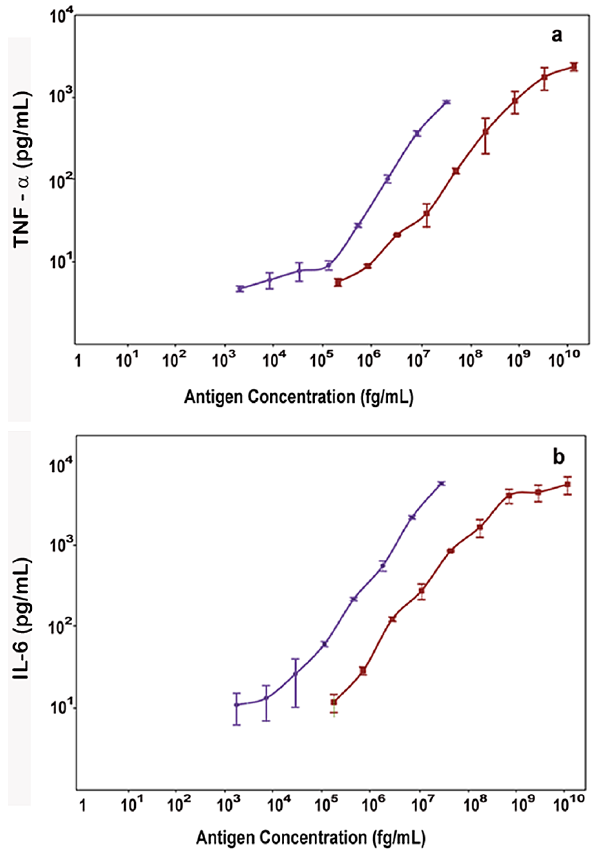
Figure 3. Measurement of the endotoxin activity of the NOMV vaccine. Measurement of endotoxin activity of the NOMV vaccine by the whole blood cytokine release assay using TNF- a and IL-6 as indicators. In Fig. 3a, the induction of TNF- a by the wild-type H44/ 76 NOMV ( circles ) and ( D lpxL1 D synX ) experimental trivalent NOMV vaccine ( squares ) is shown. In Fig. 3b, the induction of IL-6 by the wild- type H44/76 NOMV ( circles ) and ( D lpxL1 D synX ) experimental trivalent NOMV vaccine ( squares ) is shown.